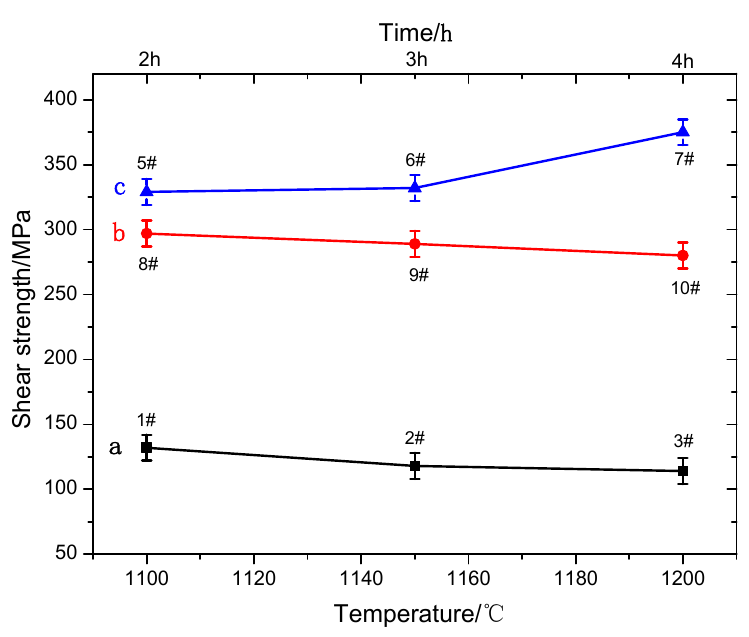
Figure 8. Shear strength of the 2205/Q235B composite steel plate.